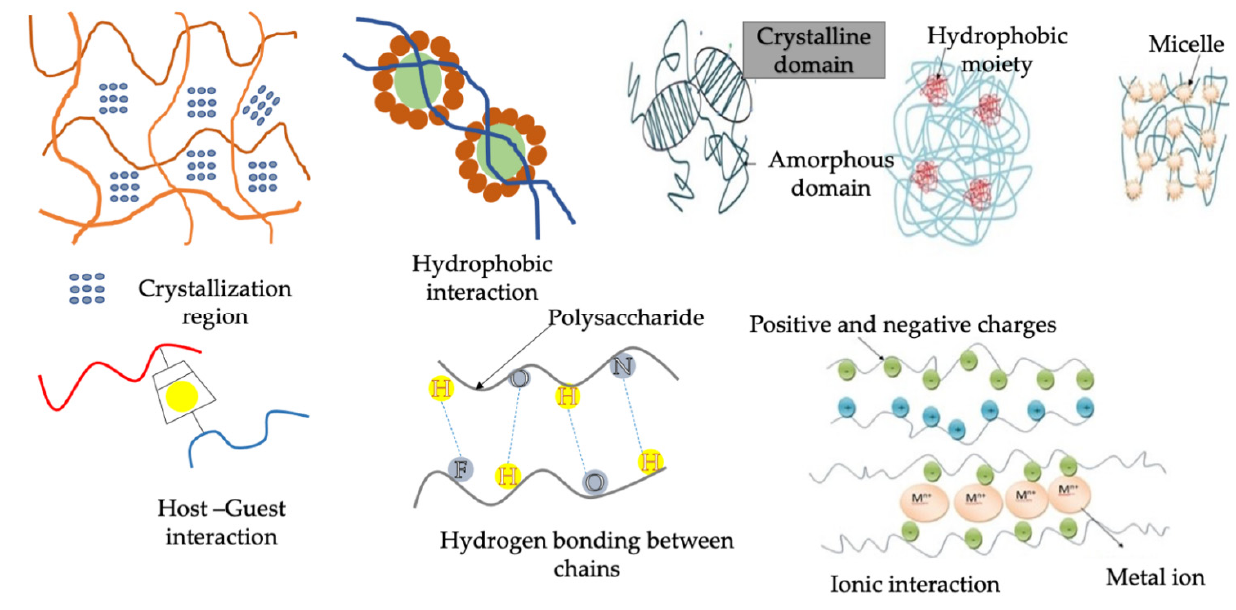
Figure 2. Physical crosslinking Figure 2 . Physical crosslinking techniques.